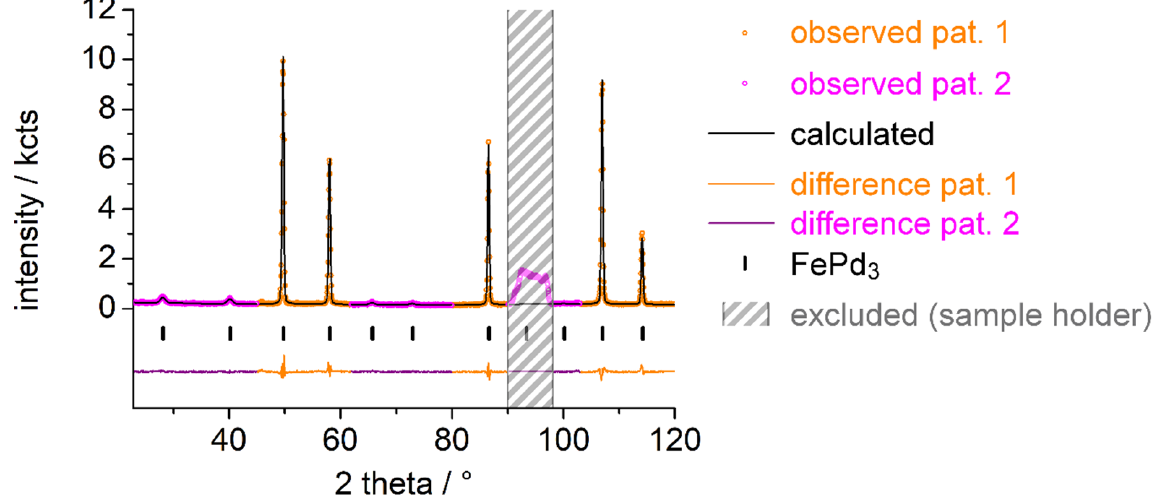
Figure A12. Rietveld refinement of the crystal structure of FePd 3 D 0.027(8) (for details, see fifth row in Tables A6 and A7) based on neutron powder diffraction data (NUMOR 131717 [21], λ = 186.80(2) pm, D20 ILL, Grenoble) in a single-crystal sapphire cell at 296(1) K and 4.00(1) MPa deuterium pressure using FullProf [24].